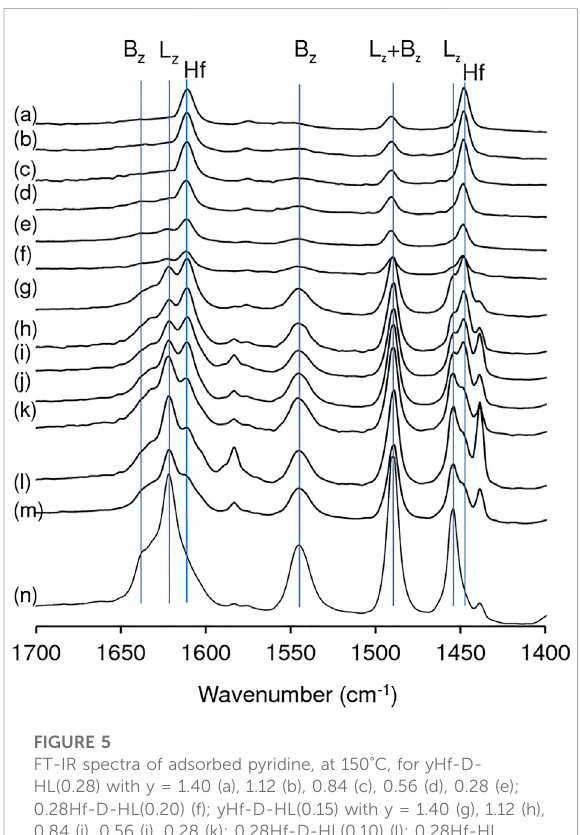
FIGURE 5 FT-IR spectra of adsorbed pyridine, at 150 ° C, for yHf-D- HL(0.28) with y = 1.40 (a), 1.12 (b), 0.84 (c), 0.56 (d), 0.28 (e); 0.28Hf-D-HL(0.20) (f); yHf-D-HL(0.15) with y = 1.40 (g), 1.12 (h), 0.84 (i), 0.56 (j), 0.28 (k); 0.28Hf-D-HL(0.10) (l); 0.28Hf-HL (m); HL (n). Hf signalizes the new bands which appeared after Hf